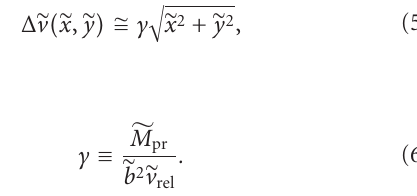
Table 1: Coe ffi cients of polynomial fits for Δ ( γ ) with varying poly- tropic